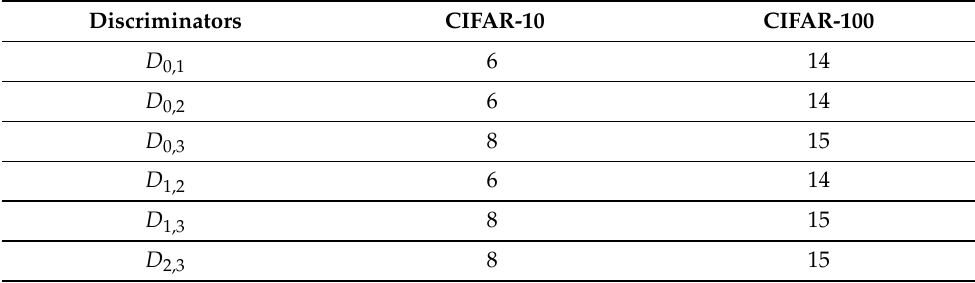
Table 1. The number of linear units in the